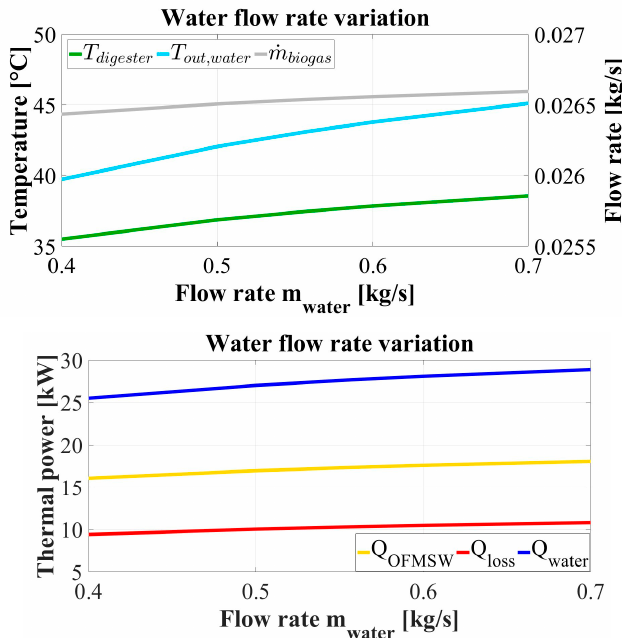
. . . Q & , Q & , Q & (below) vs. Q OFMSW , Q loss , Q water (below) vs. OFMSW loss water